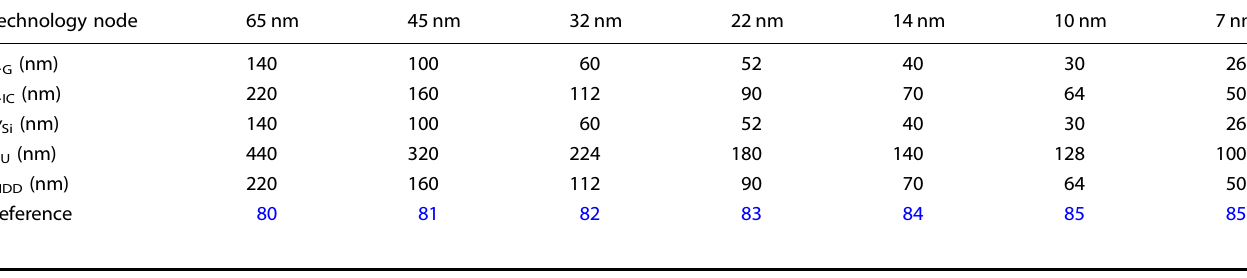
Table 2. Size (nm) of the critical features at different technological nodes and corresponding references from IEDM conferences and ITRS documents Technology node